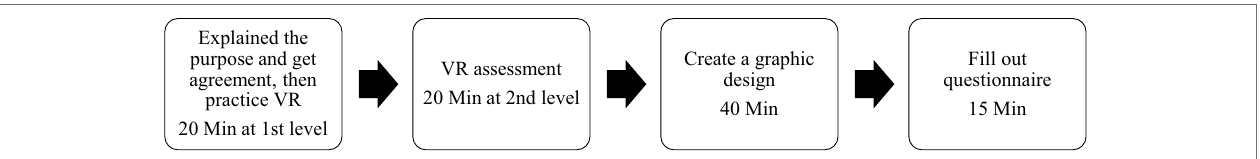
FIGURE 2 | Procedure.